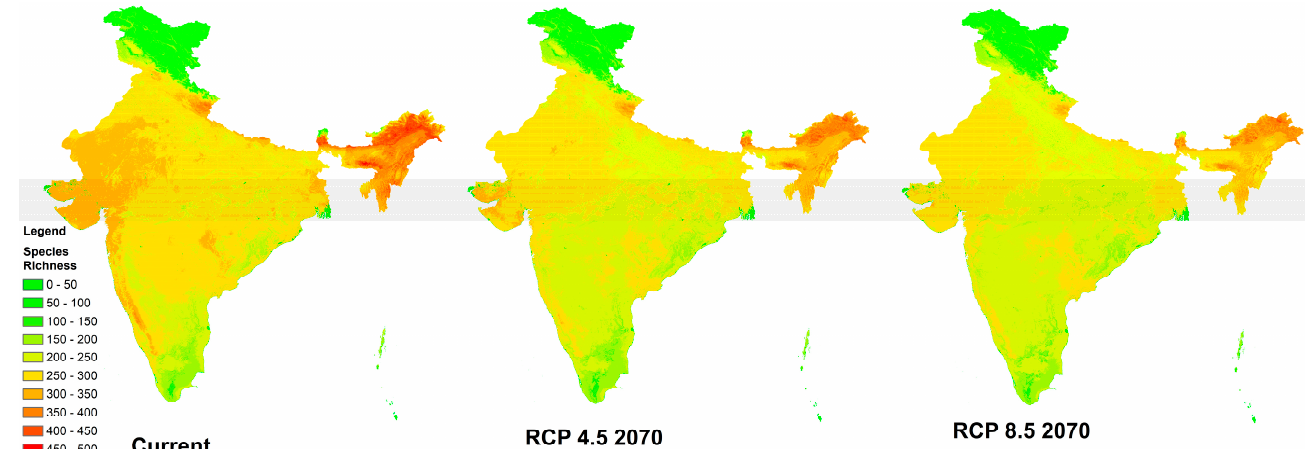
Figure 2. Habitat–wise % changes in distribution ranges of bird species in 2070 under RCP 4.5 and RCP 8.5 scenarios in India.